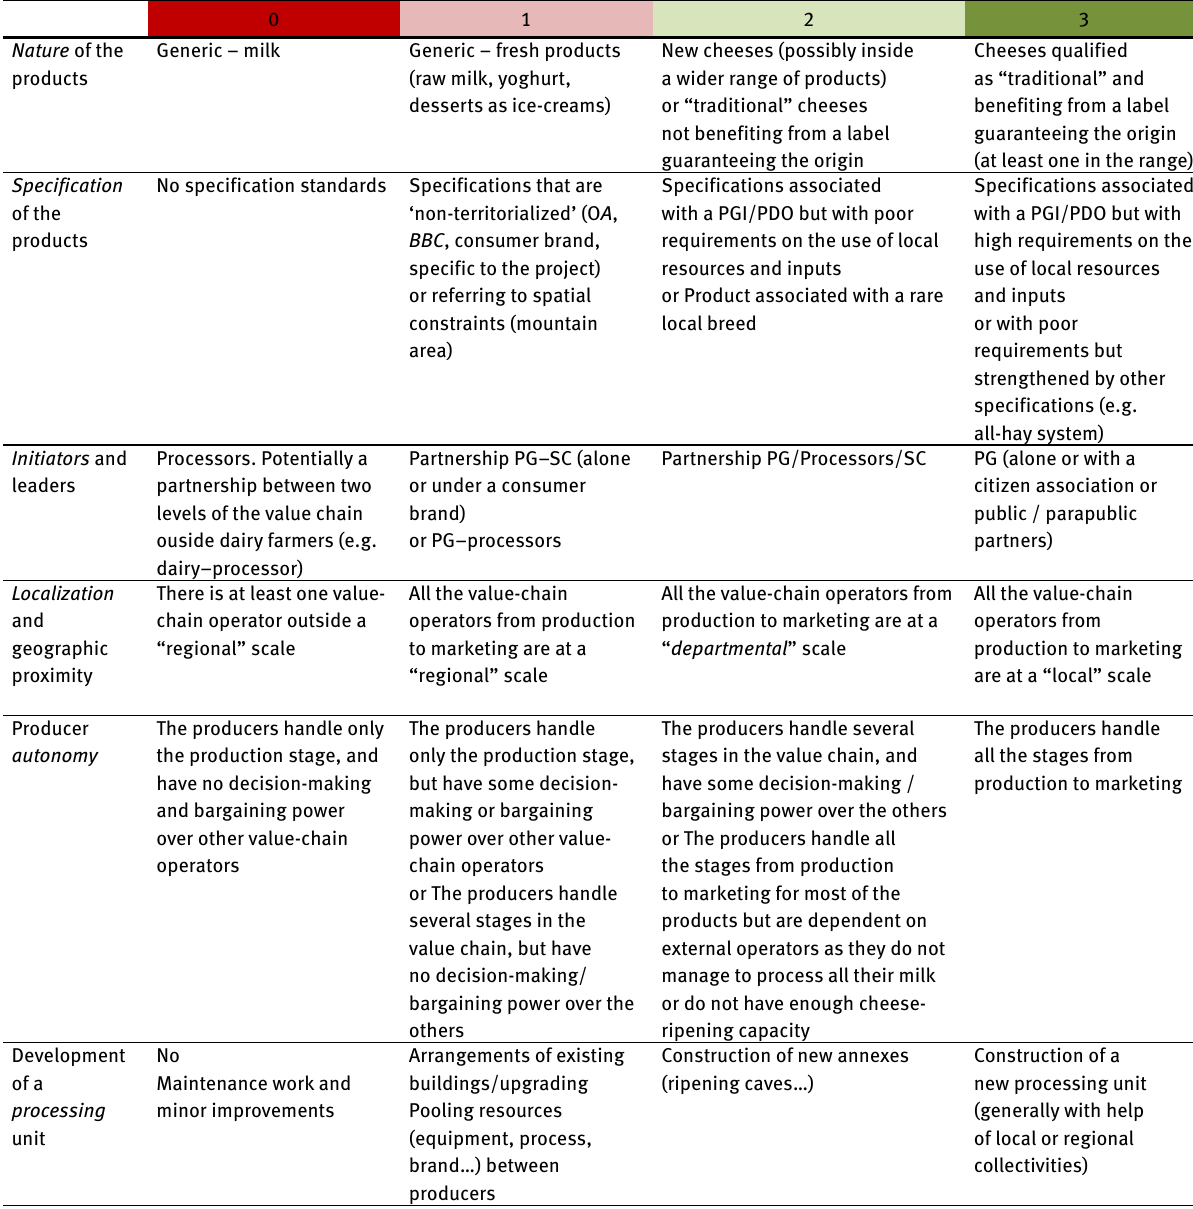
Table 1: Variables and their modalities used to analyze the forms of territorial embeddedness 0 Nature of the